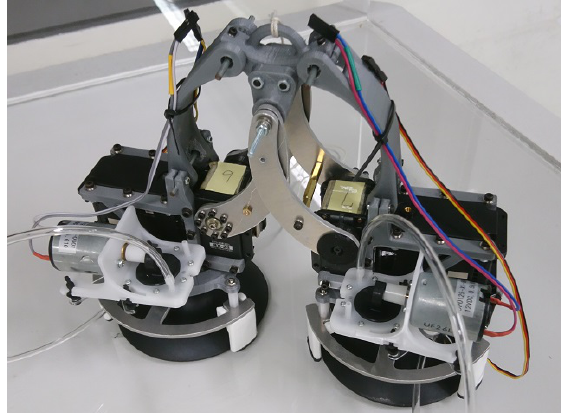
Figure 11. Photograph of the actual